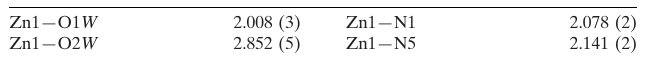
Selected bond lengths (A˚ ).